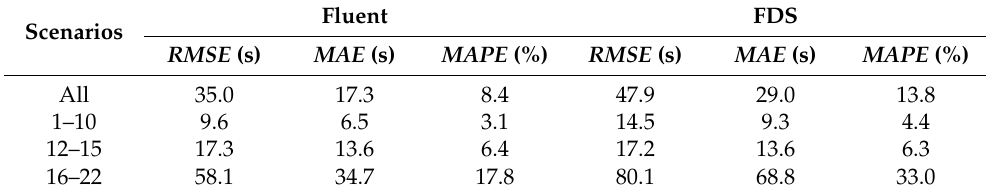
Table 8. Overview of the results accuracy.